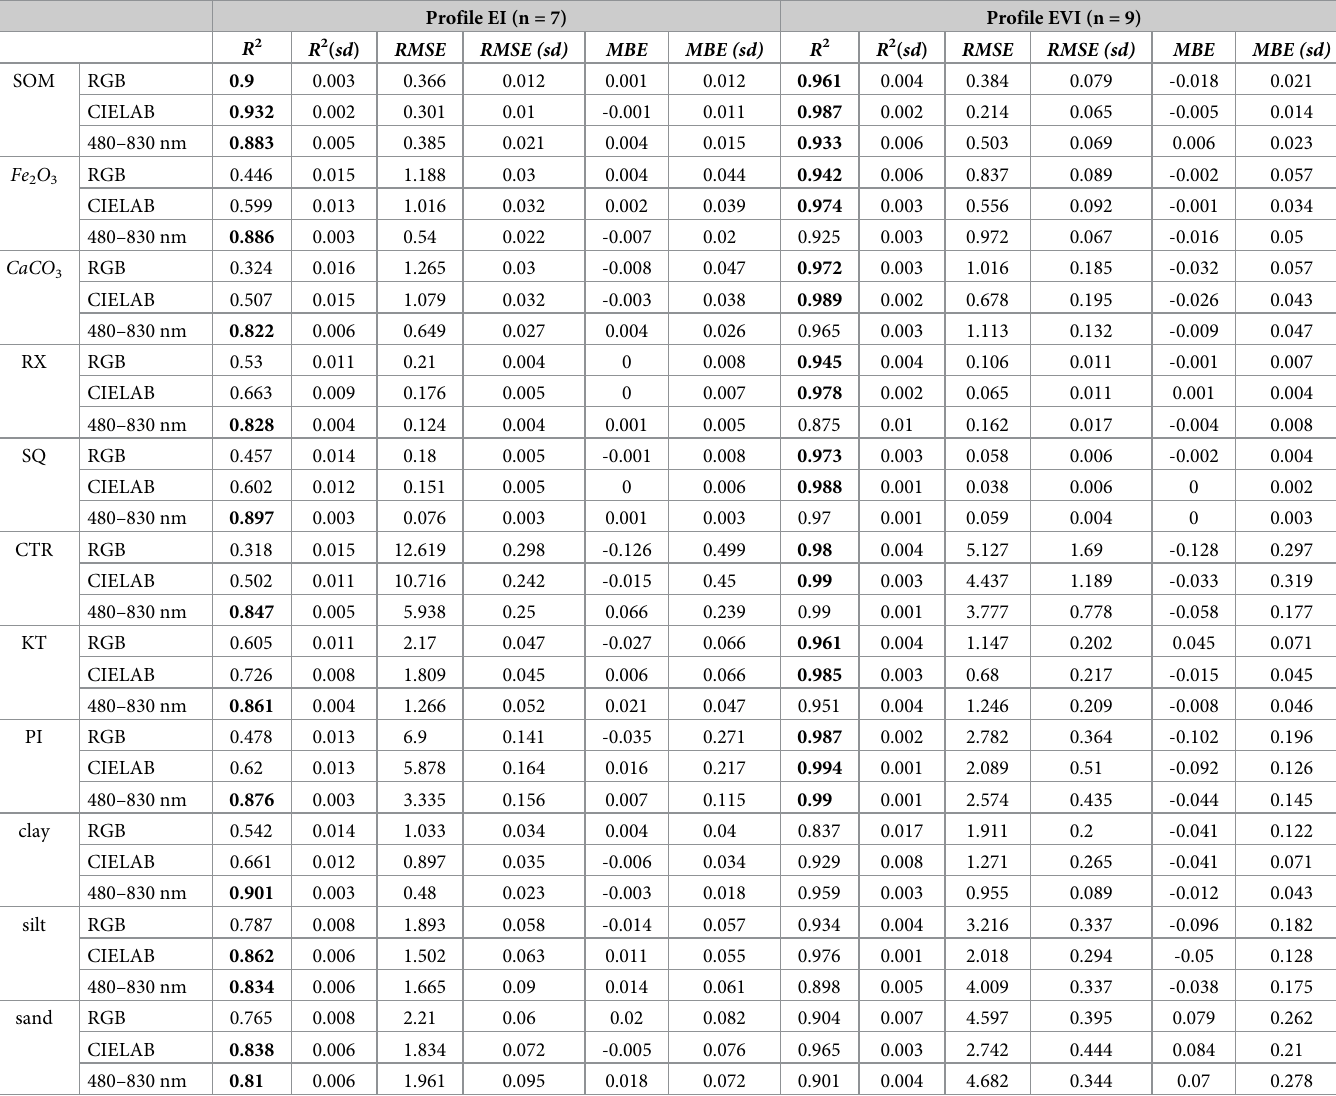
Table 4. Cross-validation results of the regression analyses using RGB, CIELAB and hyperspectral data. Mean and standard deviation of the root mean square error (RMSE), mean bias error (MBE) and pseudo R 2 values (1 − MSE / Var ( y ))obtained from leave-p-out cross-validation are reported. The training data consisted of seven sed- iment samples for profile EI and nine sediment samples for profile EVI. Significant models are marked in